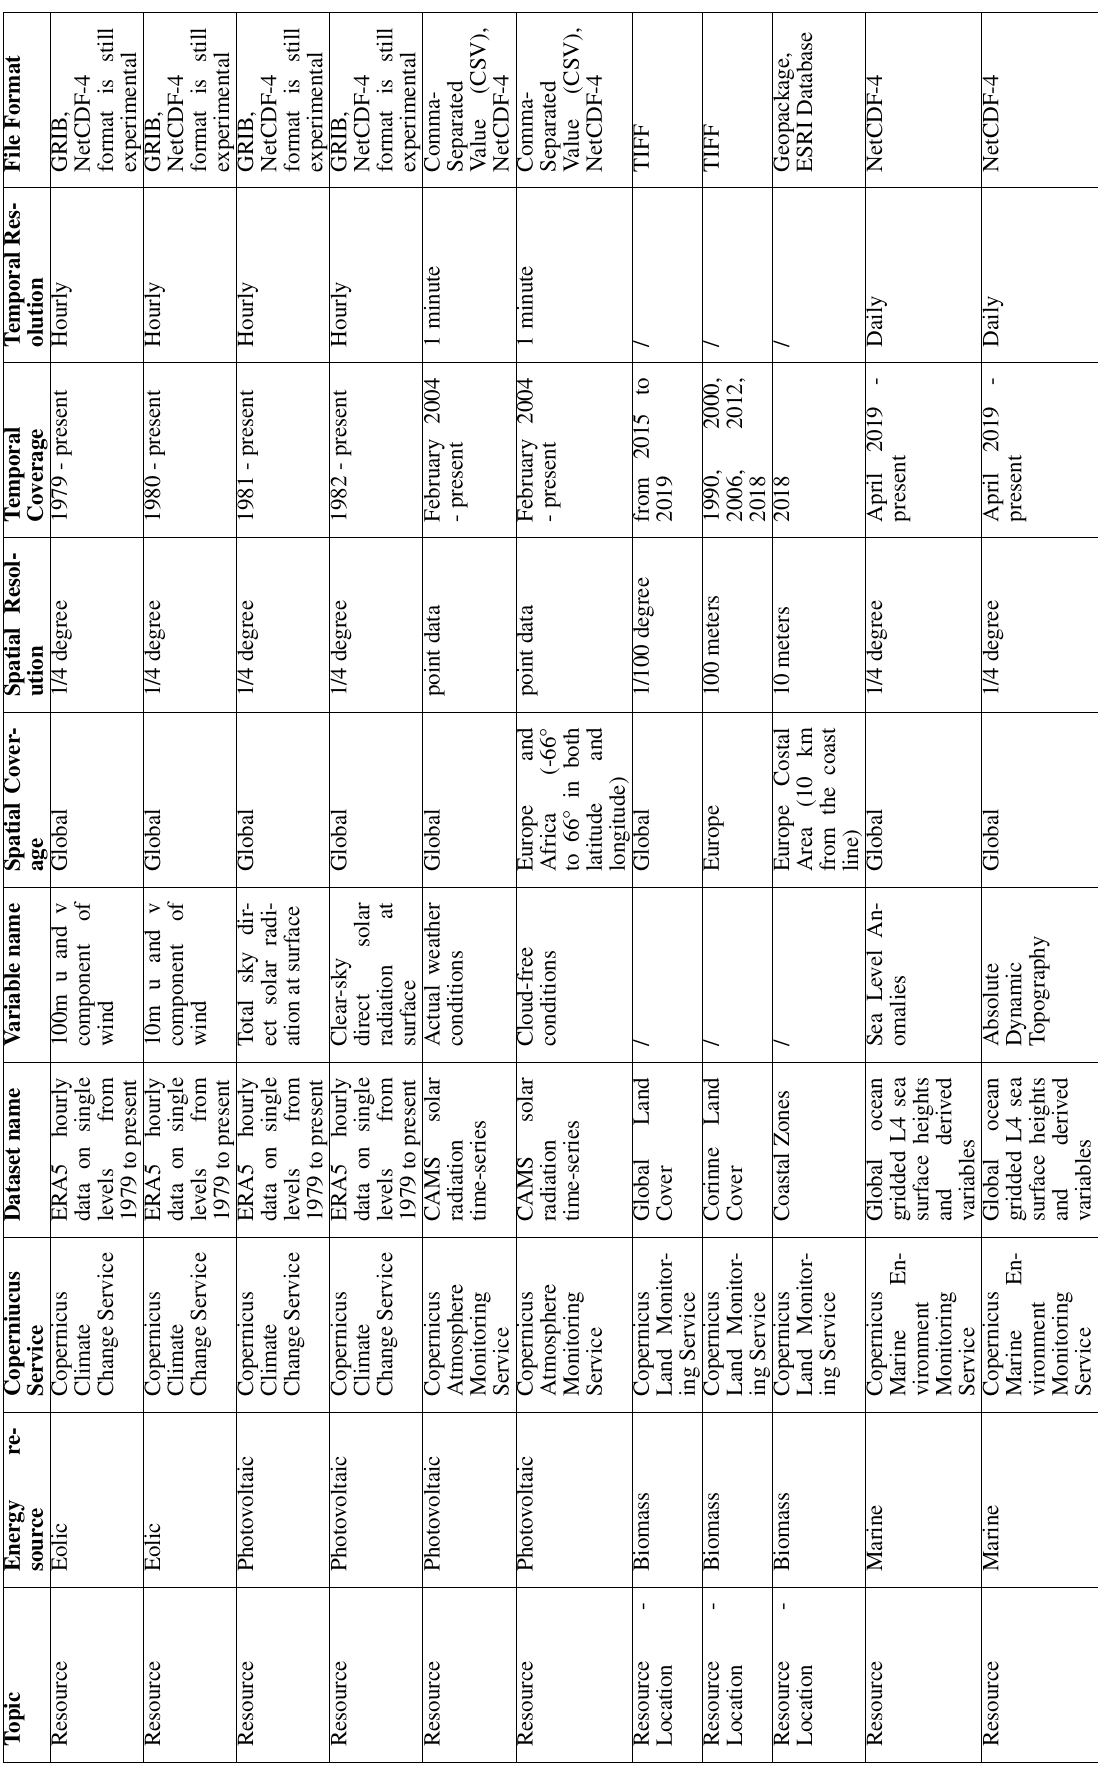
Table 2a. Datasets of interest for the energy